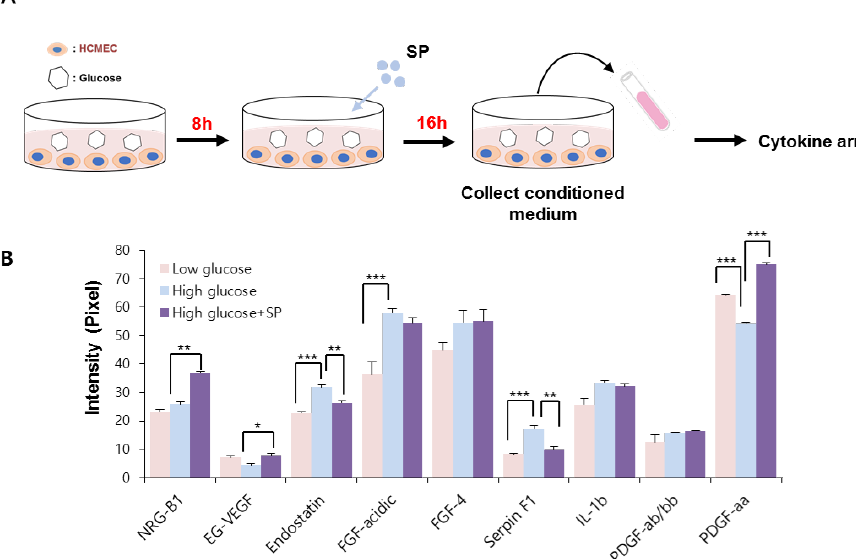
Figure 4. SP treatment prevents alteration of cytokine profile in cardiac microendothelial cells after high glucose treatment. ( A ) Experimental scheme for glucose and SP treatment. ( B ) Angiogenesis- related cytokine profile was analyzed via cytokine arrays. The relative expression was quantified using image J. Values of p < 0.05 were considered significant (* p < 0.05, ** p < 0.01, *** p < 0.001). The data are expressed as the mean ± standard deviation of three independent experiments. SP, substance-P; NRG-B1, neuregulin beta 1; EG-VEGF, endocrine gland-derived vascular endothelial growth factor; FGF, fibroblast growth factor; IL-1b, interleukin 1 beta; PDGF, platelet-derived growth factor.